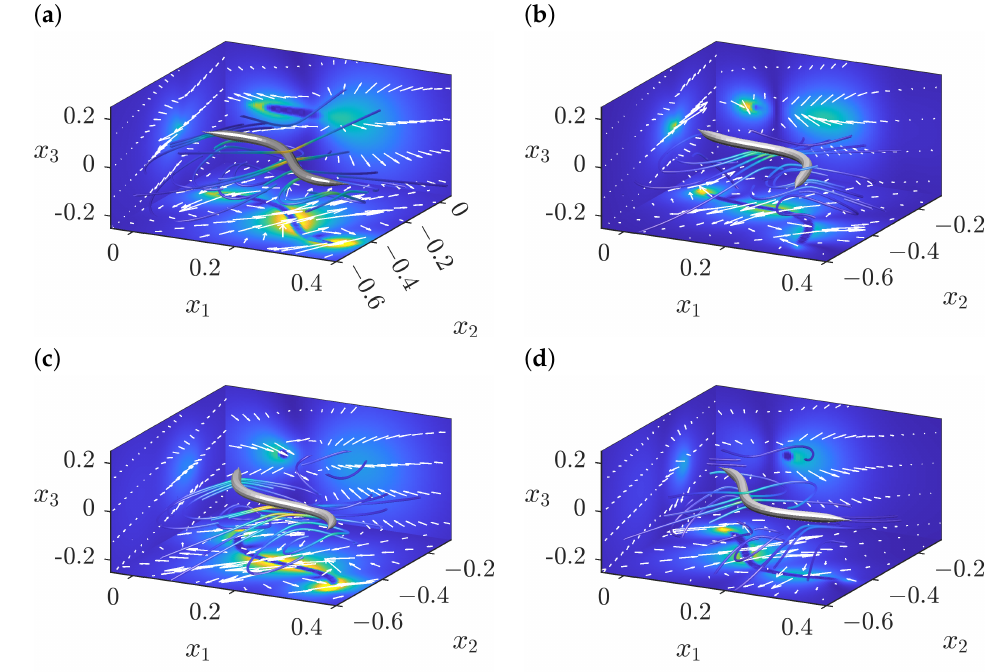
Figure 8. Undulating slender swimmer, full boundary integral calculation, with maximum radius a 0 = 0.02. ( a – d ) velocity field in the fluid with instantaneous streamlines at four approximately equally spaced intervals during the beat cycle.